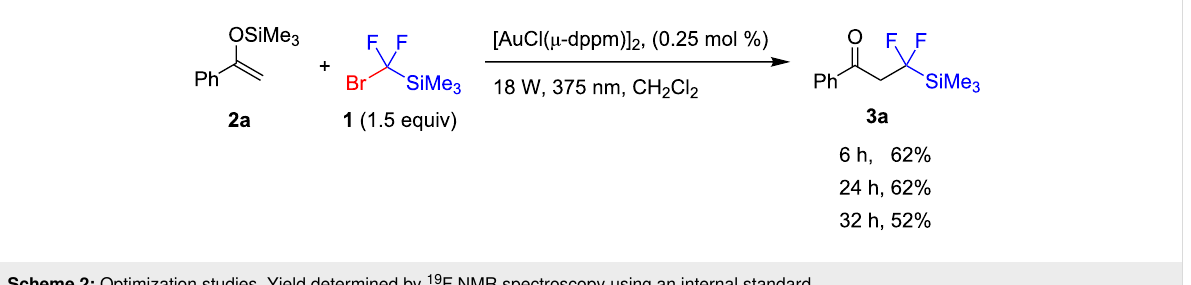
was evaluated (Scheme 2). The reactions were performed in dichloromethane, and reaction mixtures were analyzed by 19 F NMR spectroscopy. A series of typical photocatalysts